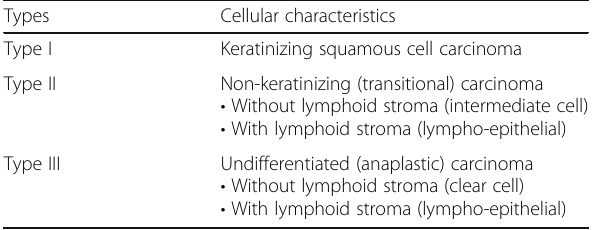
Table 5 WHO classification (pathology) for